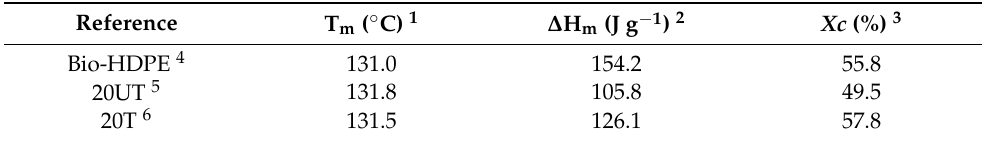
Table 3. Main thermal parameters of Bio-HDPE with untreated and treated chia seed flour obtained using DSC.